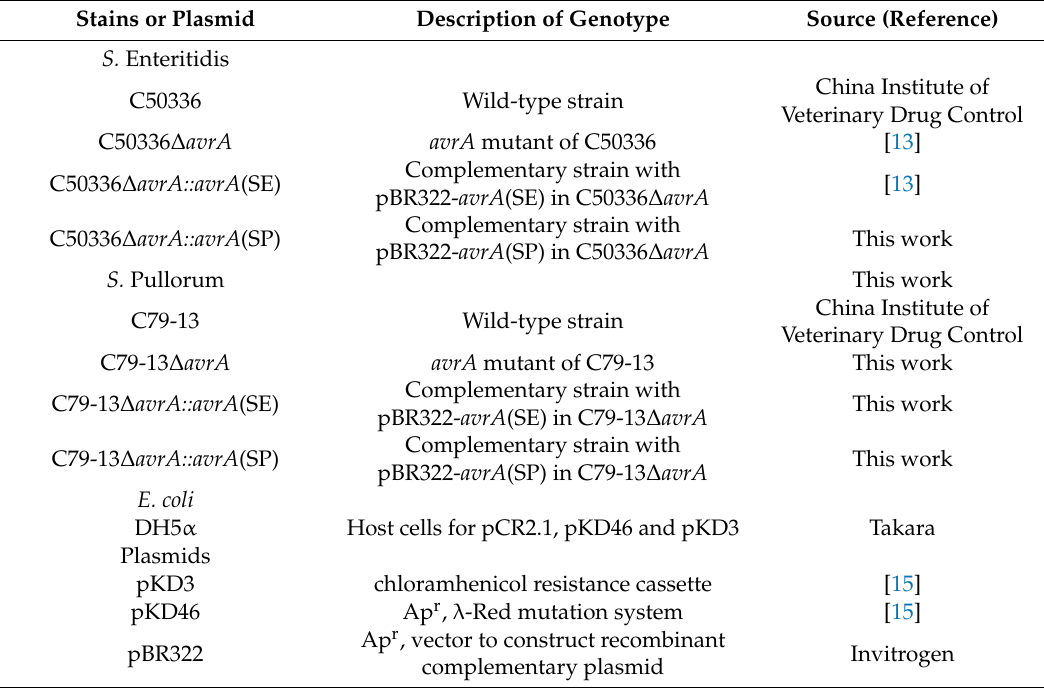
Table 1. Bacterial strains and